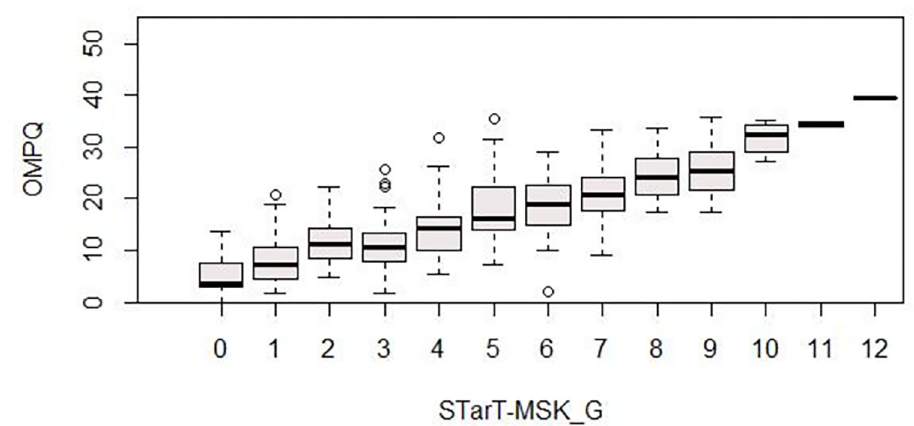
Fig 1. Relation between STarT-MSK G and OMPQ. OMPQ: O¨rebro Musculoskeletal Pain Questionnaire, STarT-MSK_G: STarT-MSK-Tool, German version.